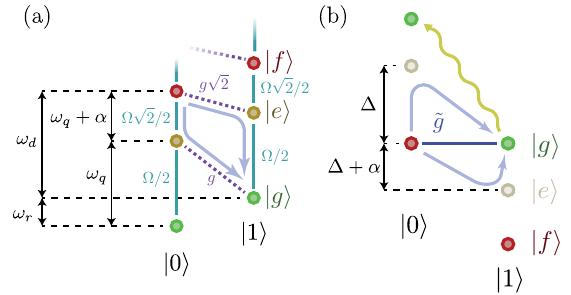
FIG. 1. (a) Energy level diagram of the qubit-resonator system. The matrix elements of the drive Ω and the Jaynes-Cummings coupling g are indicated by solid lines and dotted lines, respectively, connecting the coupled bare states. The two sec- ond-order paths connecting the states j f 0 i and j g 1 i are indicated by arrows. (b) In the rotating frame of the drive, the states j f 0 i and j g 1 i are nearly resonant. The second-order effective coupling ~ g between them after adiabatic elimination of the intermediate states j e 0 i and j e 1 i is indicated by the solid blue line. The decay of the state j g 1 i into j g 0 i by photon emission is shown by the yellow